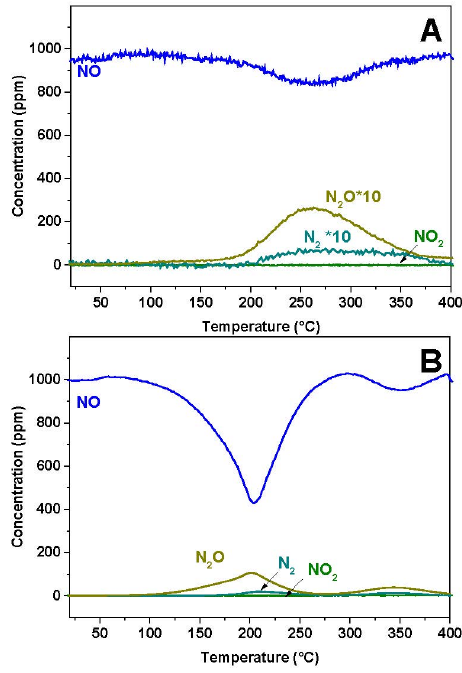
Figure 1. NO ‐ TPR experiments with NO (1000 ppm) in He from 40–400 °C (10 °C/min) over pre ‐ reduced Figure 1. NO-TPR experiments with NO (1000 ppm) in He from 40–400 ˝ C (10 ˝ C/min) over Rh ‐ BaO/Al 2 O 3 ( A ) and Pt ‐ BaO/Al 2 O 3 ( B ) catalysts (rig #1). pre-reduced Rh-BaO/Al 2 O 3 ( A ) and Pt-BaO/Al 2 O 3 ( B ) catalysts (rig #1).